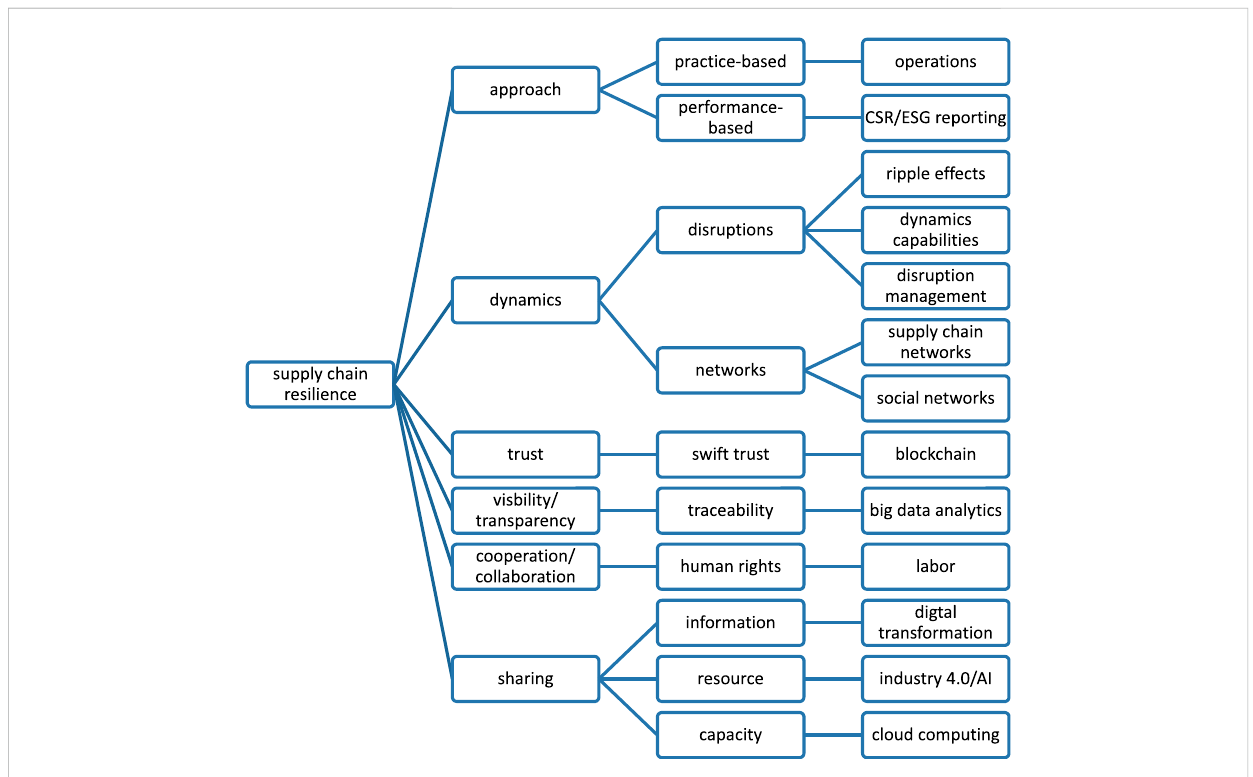
FIGURE 5 A roadmapping taxonomy for the twin green and digital transition for smart sustainable supply